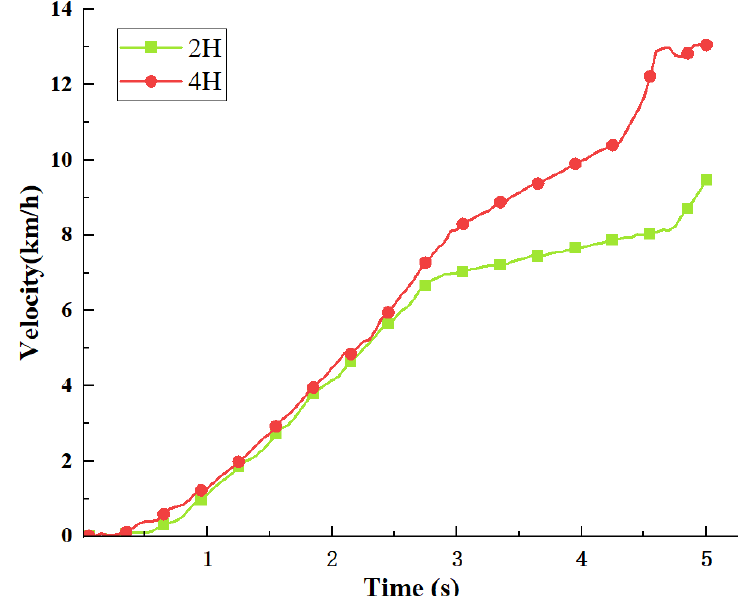
Figure 17. Opposite road test speed data.